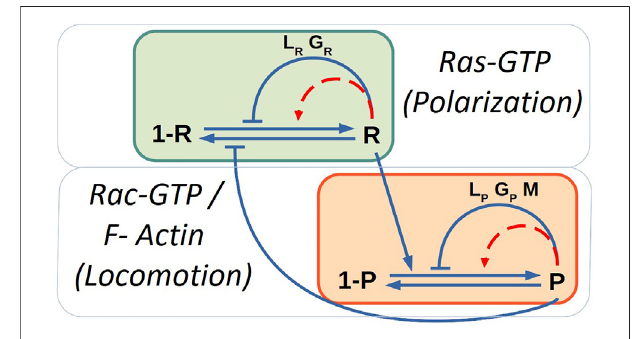
FIGURE 1 | Sketch of the biochemical model of polarization due to chemotaxis and locomotion modules. Blue solid lines corresponds to the interactions and red dashed lines to auto-catalytic processes. The mass- conservation constrains control the auto-catalytic